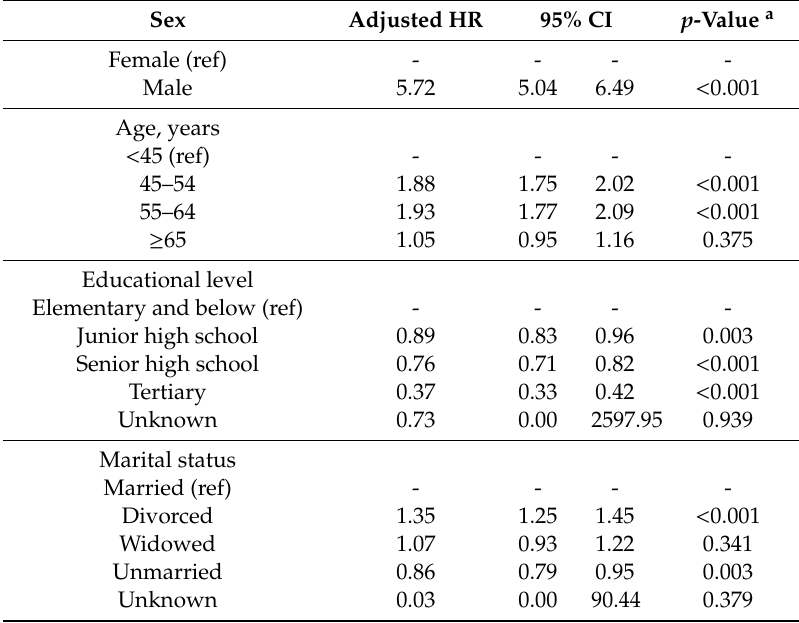
Table 3. Risk of oral cancer incidence and related factors in the high-risk population who had undergone oral cancer